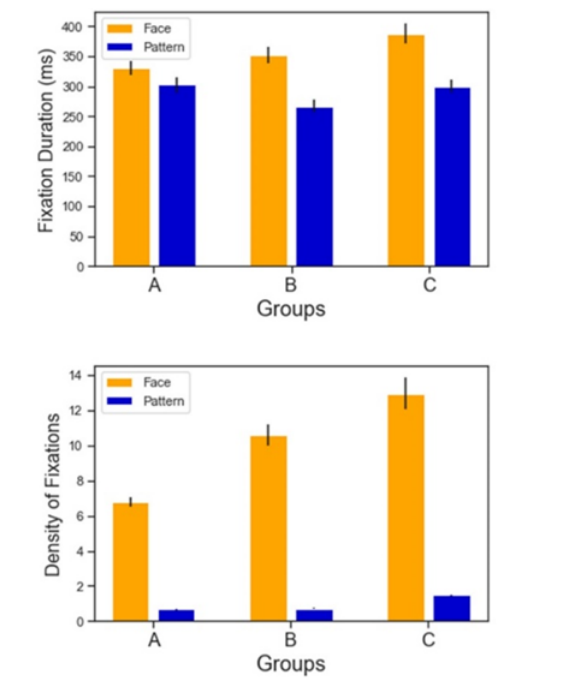
Figure 4.1: Fixation duration (ms) across groups for AOI Face (Yellow) and AOI Pattern (Blue)